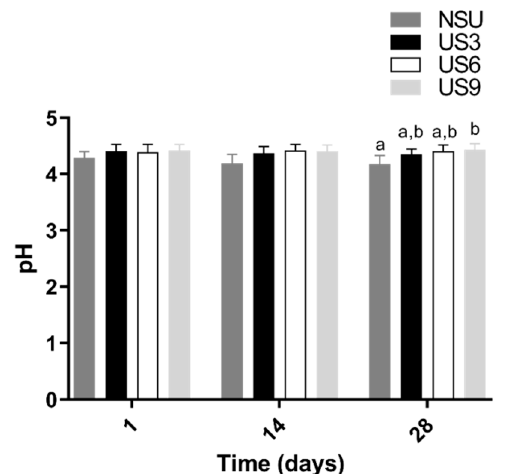
Figure 2. Changes in pH values in goat milk yogurt samples during storage at 4 °C. a–b Different lowercase letters indicate statistical differences between ultrasound treatments in goat milk